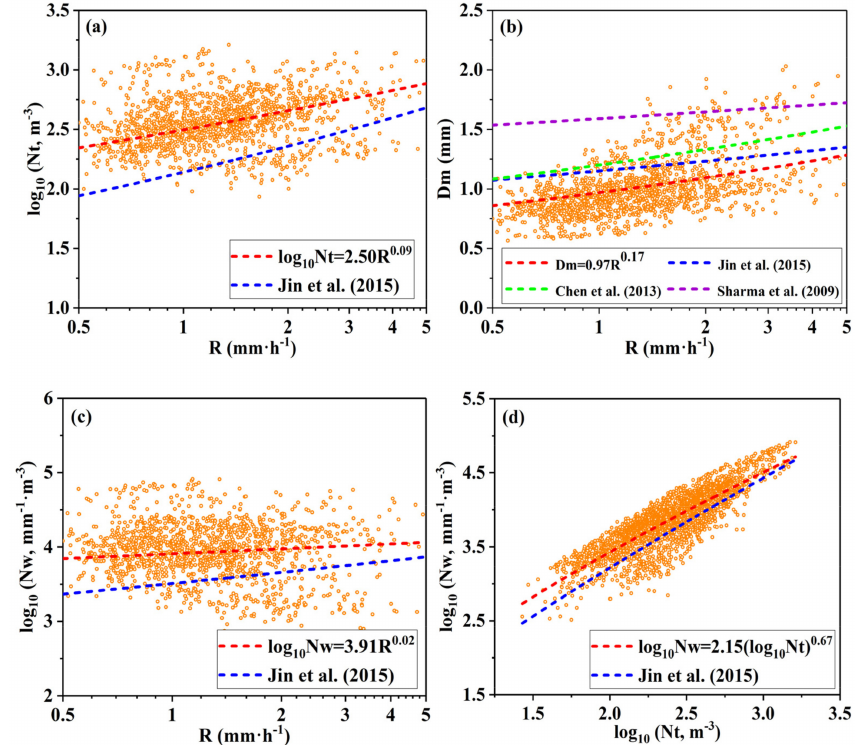
N t − R relationship, ( b ) scatterplots of the D m − R relationship, ( c ) Figure 6. ( a ) Scatterplots of the log 10 N w − R relationship, and ( d ) scatterplots of the log scatterplots of the log 10 The red dashed curve is the fitted curve for stratiform precipitation in